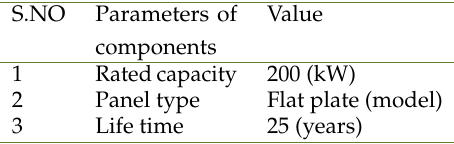
Table 1. Solar PV